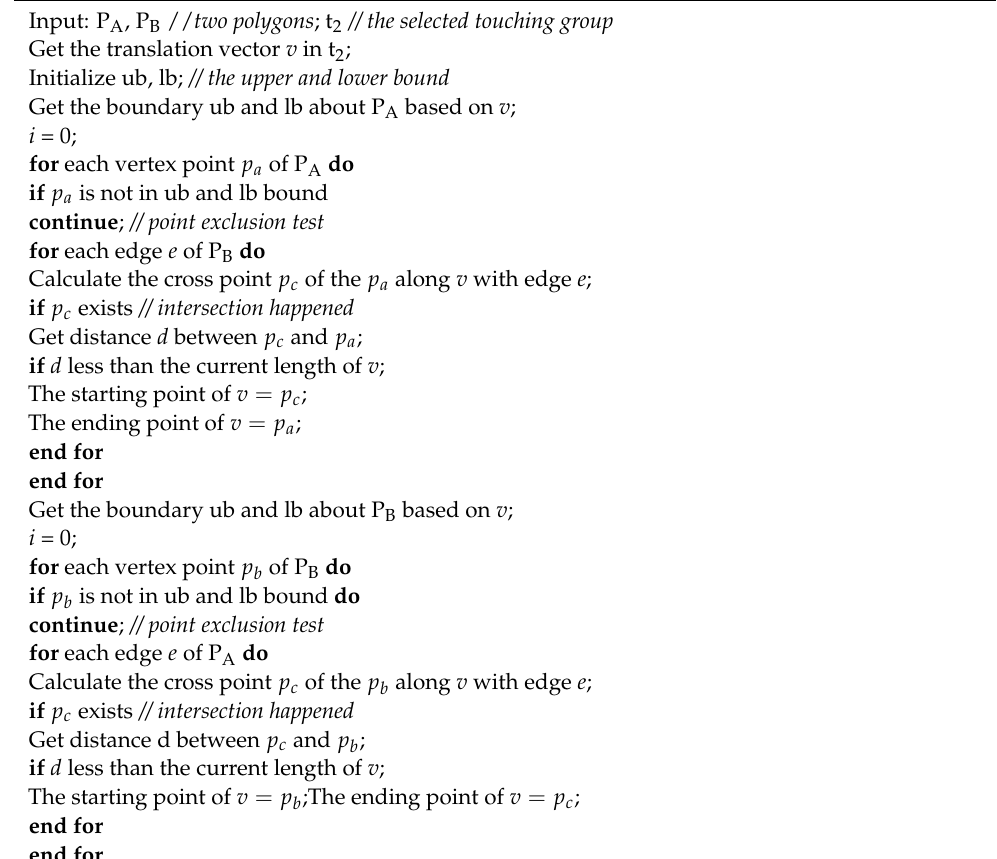
Algorithm 2: Compute translation distance.